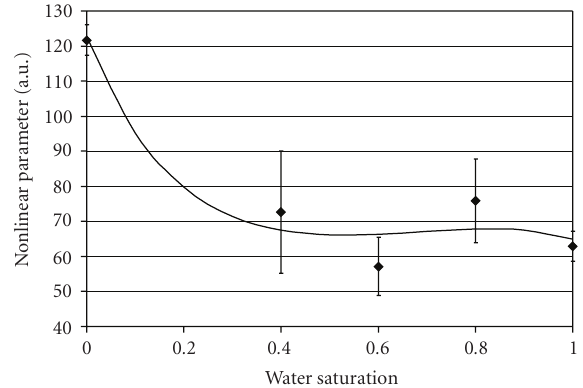
Figure 8: Dependence of the nonlinear parameter on the degree of water